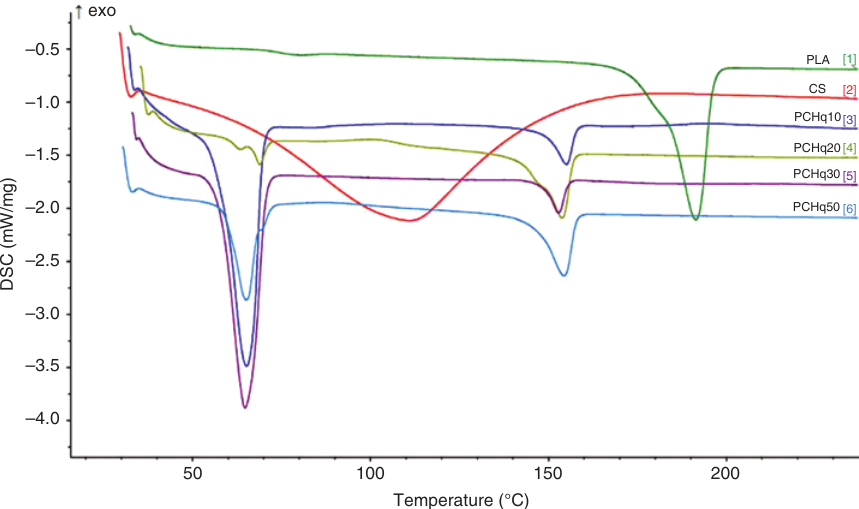
Figure 3: Differential scanning calorimetry diagrams of PLA, CS, and PCHq nanoparticles using different Hq